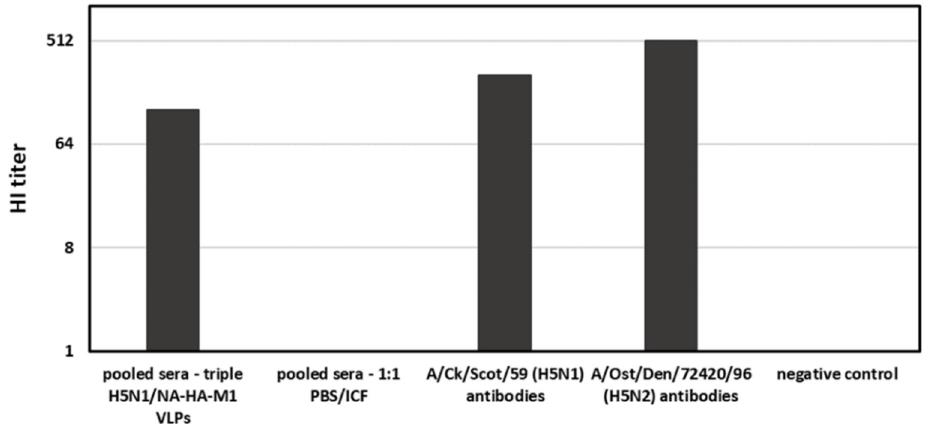
Figure 6. HI titer of pooled chicken sera collected after immunization with triple H5N1/NA-HA-M1 VLPs. H5N1 A/Ck/Scot/59 and H5N2 A/Ost/Den/72420/96 antibodies were used as a positive control. Sera from chickens vaccinated with PBS/ICF mixture served as a negative control. HI assay was performed in triplicates.